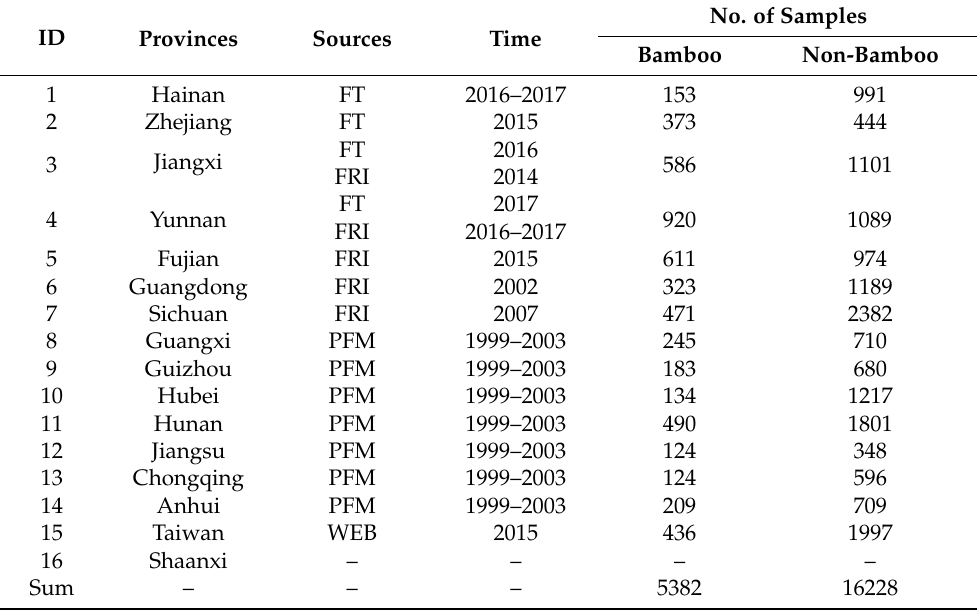
Table 1. Details of collected samples, where FT represents the field under investigation, FRI represents the forest resources inventory, and PFM represents the plantation forest